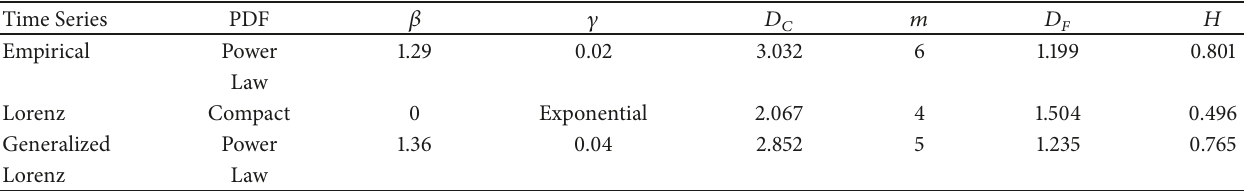
Table 1: Characteristics of empirical and theoretical time